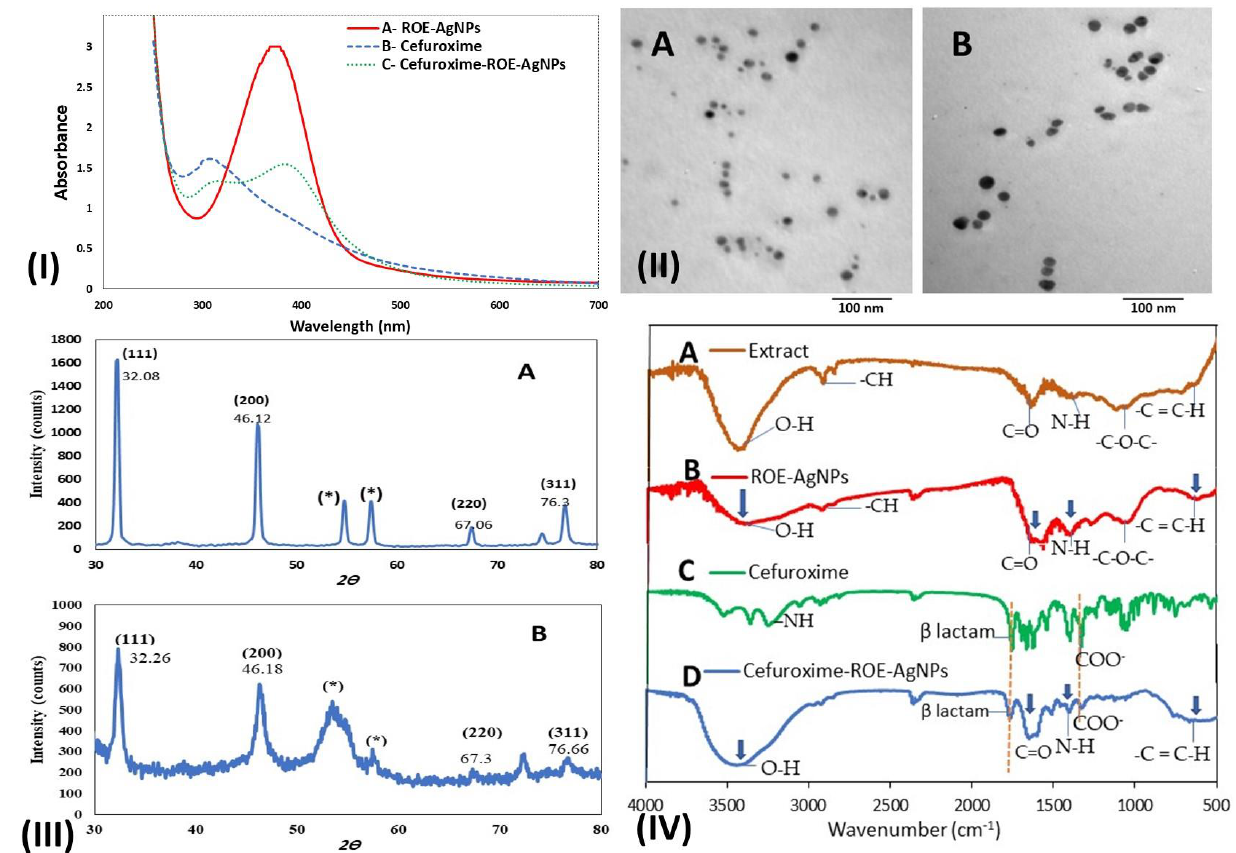
Figure 2. ( I ) Biosynthesis of AgNPs. Notes: UV-Vis spectra of ROE-AgNPs (A) conjugated with cefuroxime (B) to form Cefuroxime-ROE-AgNPs (C). ( II ) TEM images of the ROE-AgNPs synthesized using R. officinalis extract (A) and Cefuroxime-ROE-AgNPs (B). ( III ) XRD patterns of the synthesized ROE-AgNPs (A) and Cefuroxime-ROE-AgNPs (B); “*” reveal to residual materials and the numbers in brackets represent the planes of Ag face-centered cubic crystal structures. ( IV ) FTIR spectra of R. officinalis extract (A), the synthesized ROE-AgNPs (B), Cefuroxime (C), and Cefuroxime-ROE-AgNPs (D).